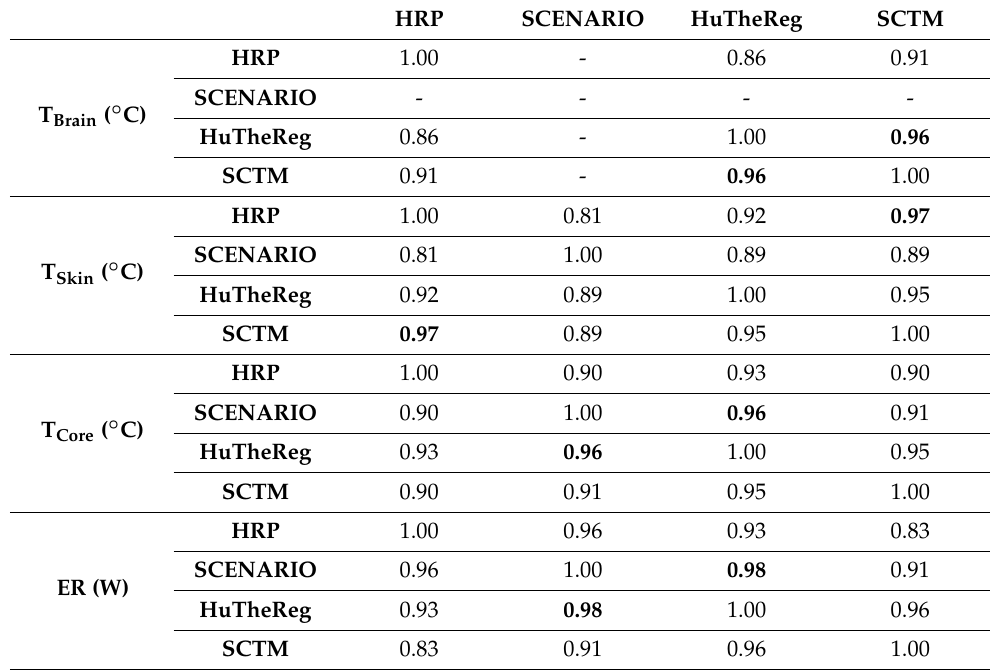
Table 6. Correlation between models predictions for moderate working profile G_12.